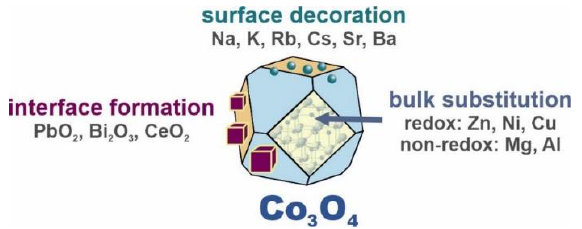
Figure 9. Graphical presentation of the promotional effects of cobalt spinel in terms of various localization of dopants.